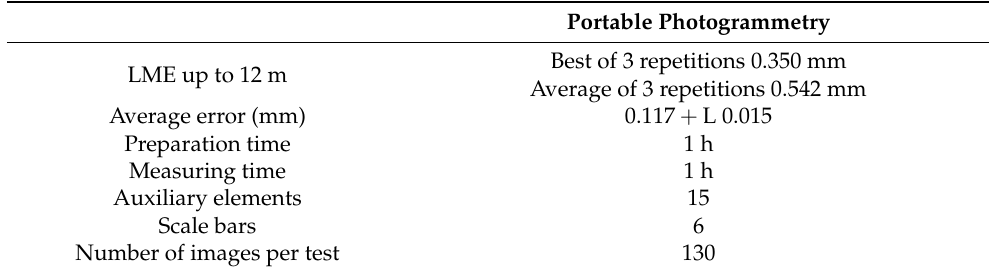
Table 6. Performance summary of the datasets to evaluate the capabilities of the photogrammetry system